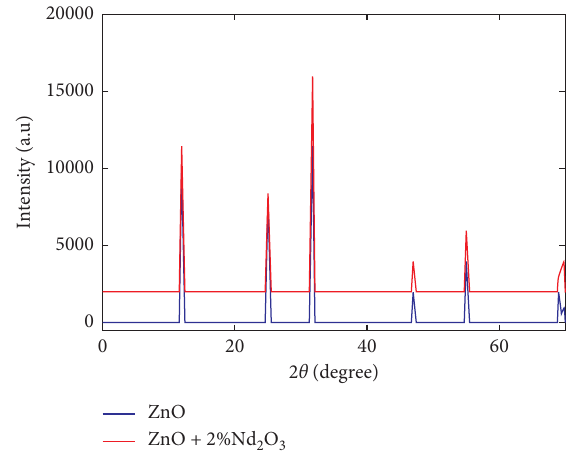
Figure 5: XRD spectrum of conductive ZnO